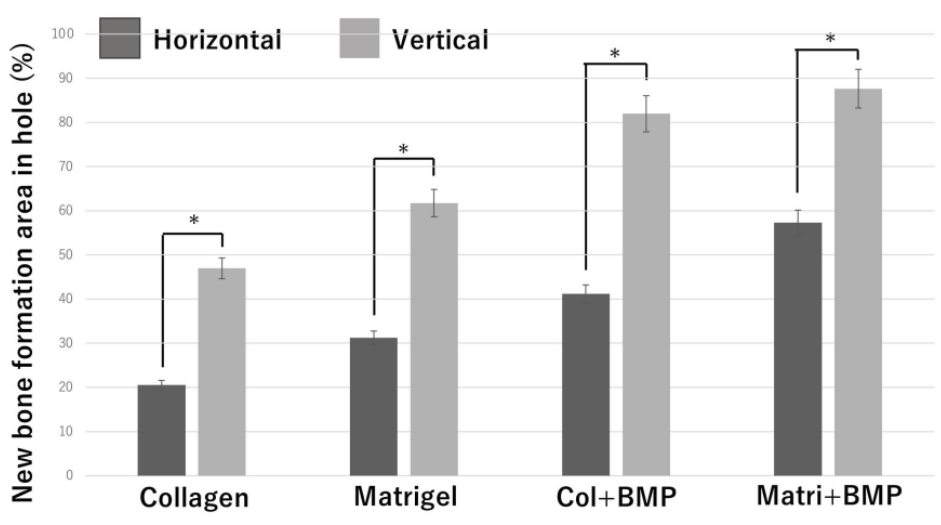
Figure 8. Quantification of the new bone tissue area in the β -TCP holes. *: p <